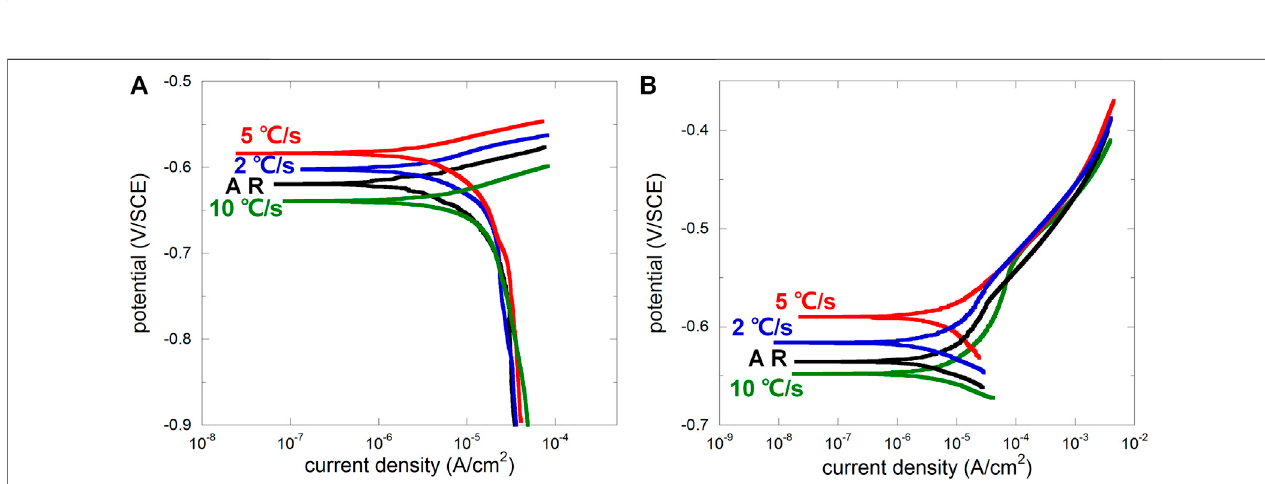
FIGURE 3 | Cathodic (A) and anodic (B) polarization curves of the as-received sample (AR) and the samples after heat treatment with cooling rates 2 ° C/s, 5 ° C/s, and 10 ° C/s.